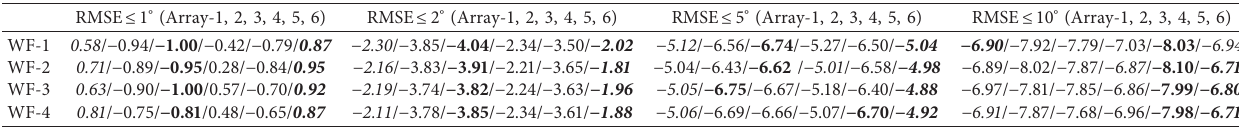
Table 2: SNR (dB) values when arrays can produce 50% correct results using 129 snapshots under different estimation accuracies. RMSE ≤ 1 ° (Array-1, 2, 3, 4, 5, 6) RMSE ≤ 2 ° (Array-1, 2, 3, 4, 5, 6) RMSE ≤ 5 ° (Array-1, 2, 3, 4, 5, 6)